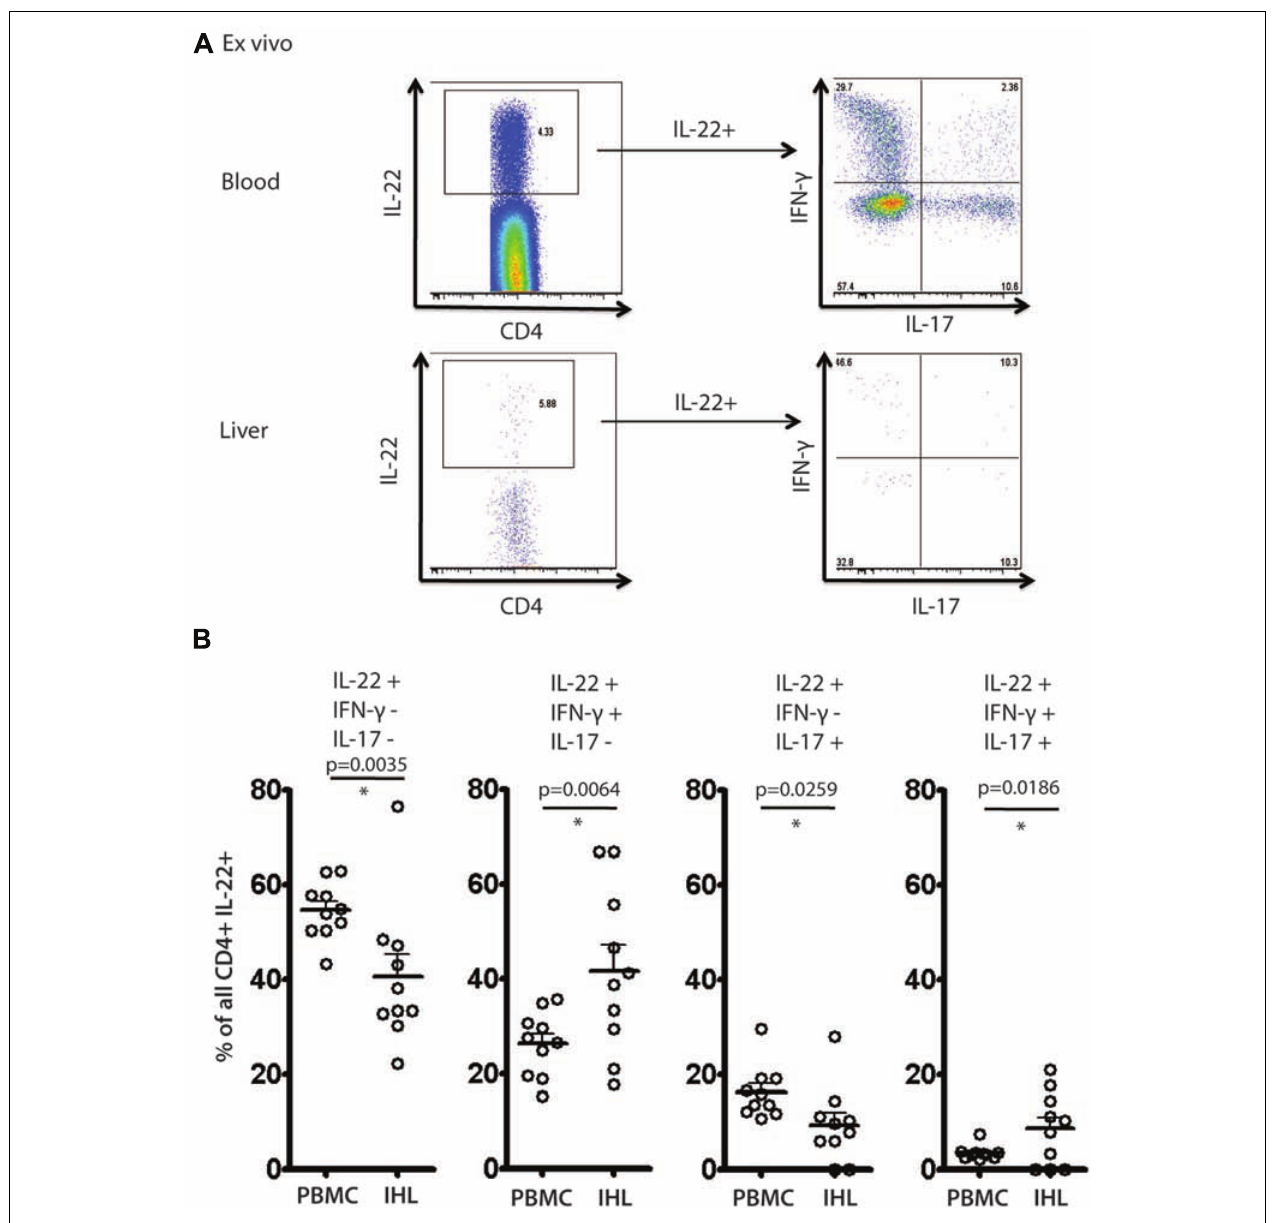
FIGURE 6 |Analysis of IL-22 secretion and polyfunctionality in blood and liver derived lymphocytes studied directly ex vivo . Liver derived lymphocytes and PBMCs were analyzed in parallel directly following isolation for expression of cytokines IL-17A, IL-22 and IFN- γ in response to PMA/Ionomycin stimulation. In (A) an example of staining is shown. IL-22 +